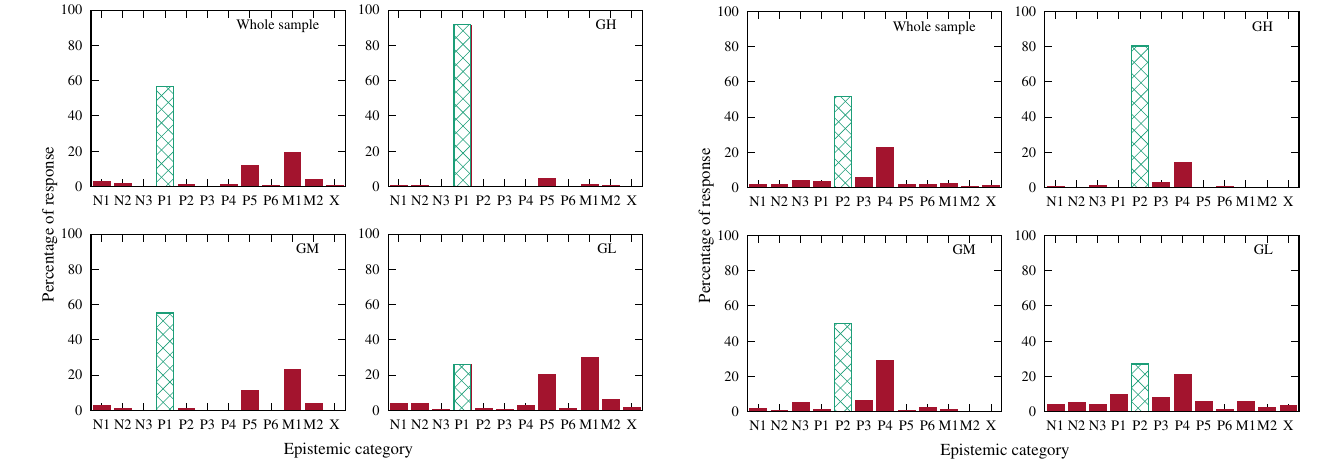
FIG. 7. Aggregate distribution of responses to all propositions (S4, S6) corresponding to epistemic category P2. Format of the figure is the same as in Fig.